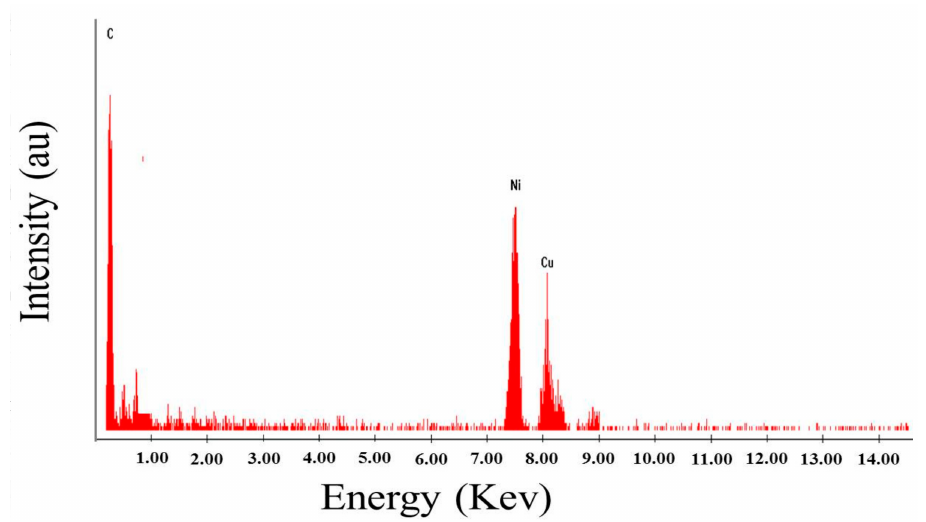
Figure 2. Elemental EDX analysis of the produced nanofibers